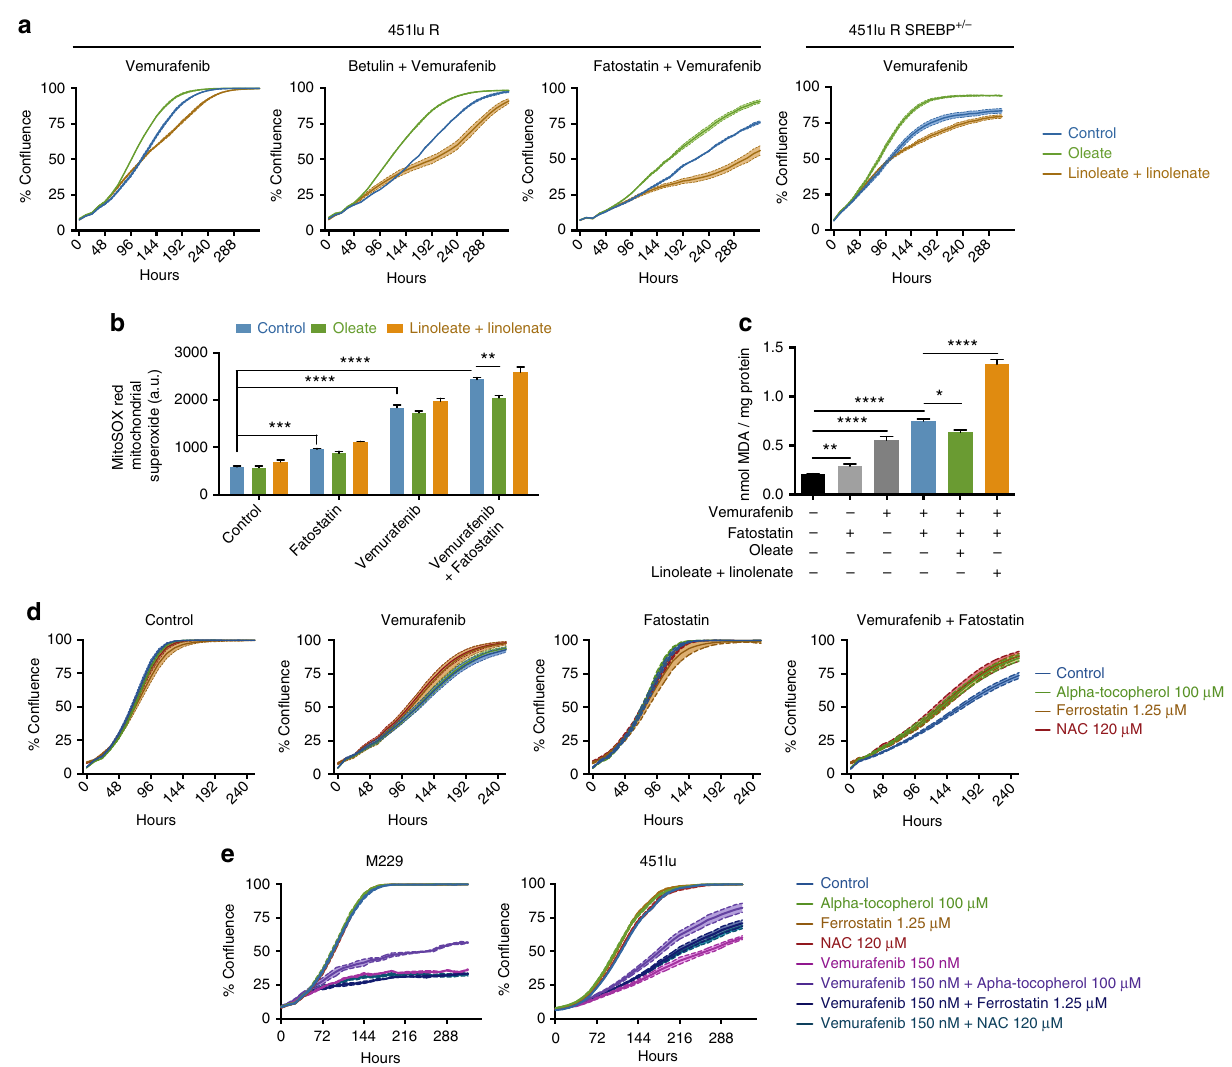
Fig. 4 Re-sensitization to vemurafenib involves lipid peroxidation. a Oleate (20 μ M) or a mixture of linoleate (10 μ M) + linolenate (10 μ M) was added to the culture medium of 451lu R SREBP + / − cells and 451lu R cells treated with either vemurafenib alone or a combination with fatostatin or betulin, raw images and bar graph are shown in Supplementary Figs. 23, 24 ( n = 3). b Mitochondrial superoxide levels in 451lu R cells treated with vemurafenib and fatostatin; medium was supplemented with oleate or linoleate + linolenate ( n = 3). c MDA levels normalized to protein content in 451lu R cells ( n = 5). d Effect of alpha-tocopherol, ferrostatin and NAC supplementation on proliferation curves of 451lu R cells treated with vemurafenib + fatostatin, raw images and bar graph are shown in Supplementary Figs. 26, 27 ( n = 4). e Proliferation curves of the therapy-sensitive cell lines M229 and 451lu treated with vemurafenib, alpha-tocopherol, ferrostatin, and NAC (phase contrast density measured by the Incucyte system) raw images and bar graph are shown in Supplementary Figs. 30, 31 ( n = 3). All data are represented as mean ± s.e.m. (* p < 0.05, ** p < 0.01, *** p < 0.001, **** p <